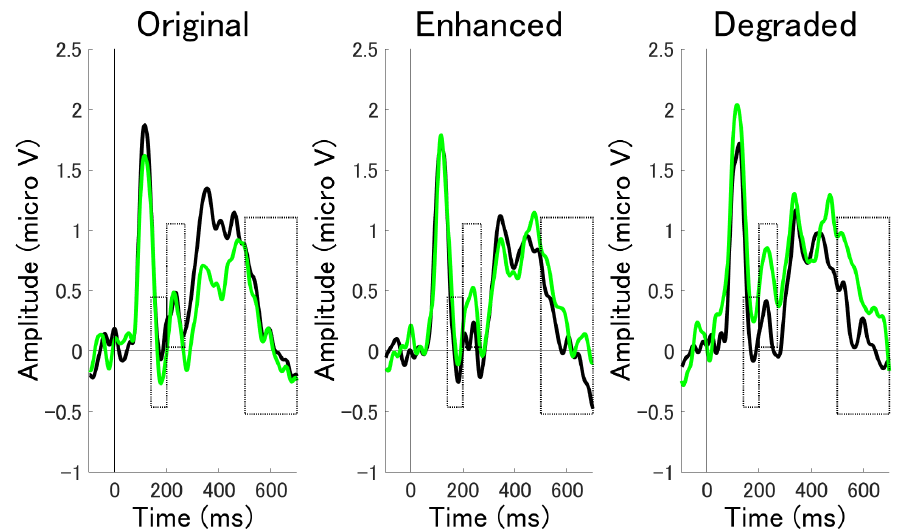
Figure 4. ERP waveforms recorded in each condition at left occipito-temporal electrode cluster. The black and green lines represent ERP waveforms for self and other familiar faces, respectively. The rectangles drawn by the dotted line represent time windows used for mean amplitude measurement of N170, P250 and LPC, respectively.